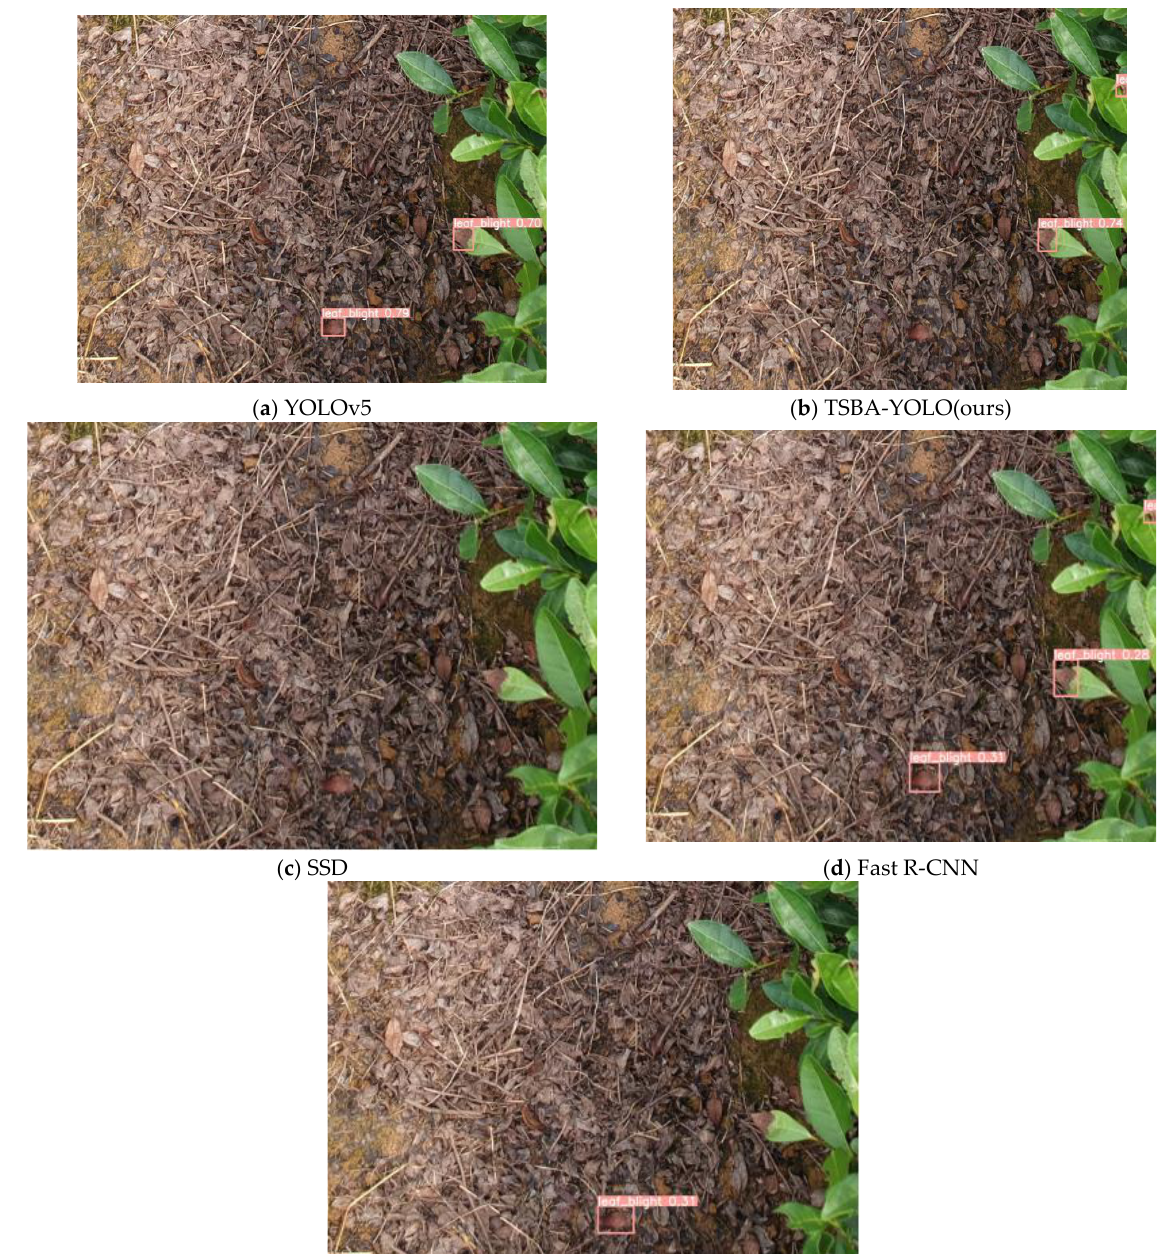
Figure 16. Comparison of anti-interference ability of different models in complex backgrounds. ( a – e ) are the detection results of the different models.